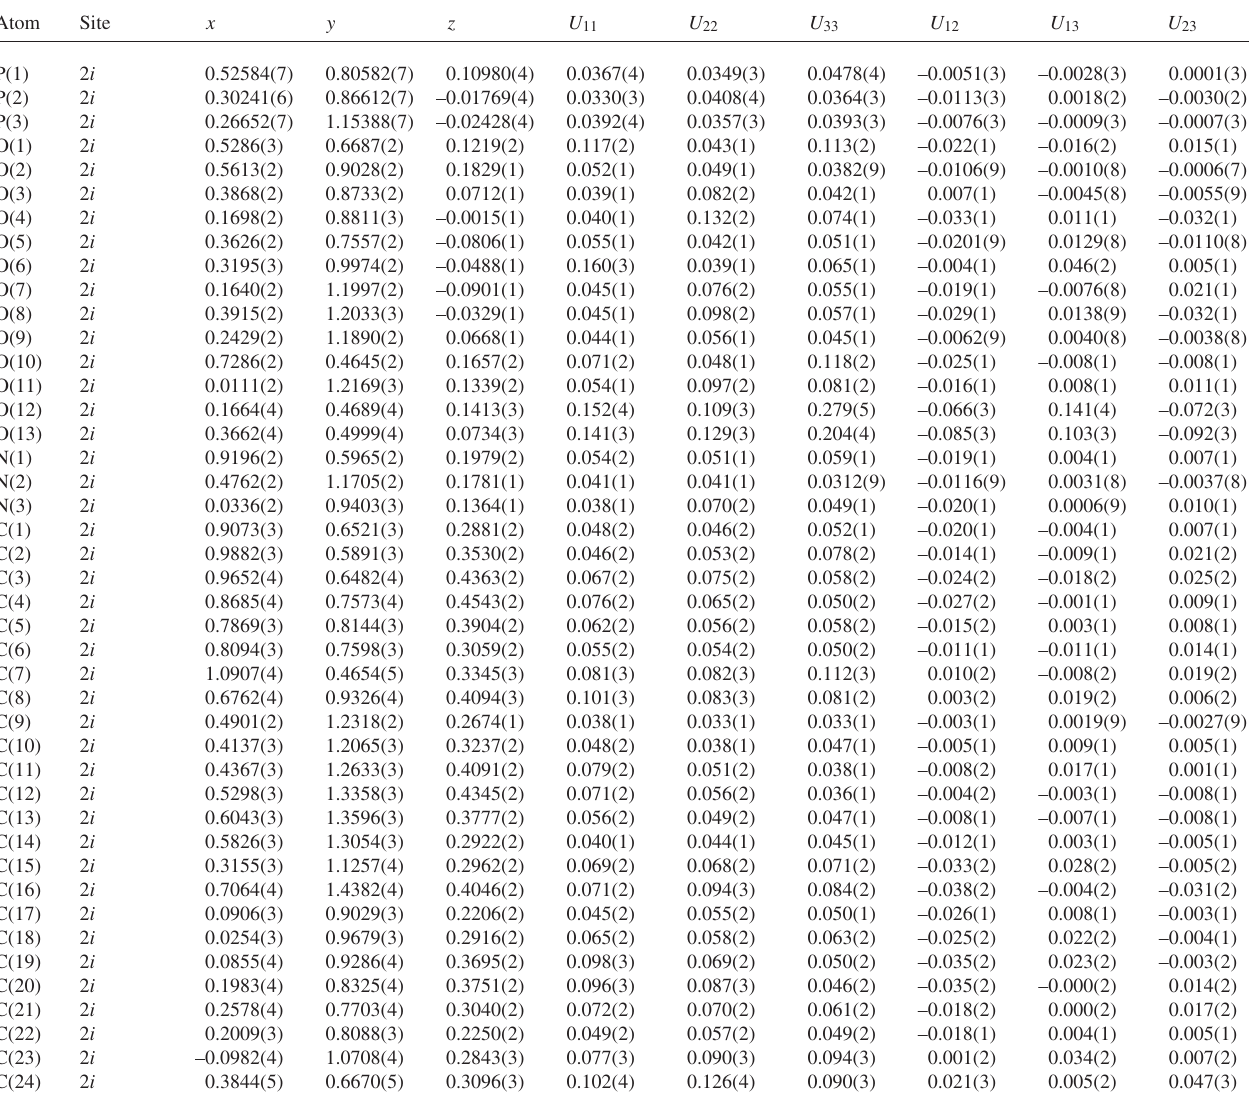
Table 3. Atomic coordinates and displacement parameters (in Å 2 )